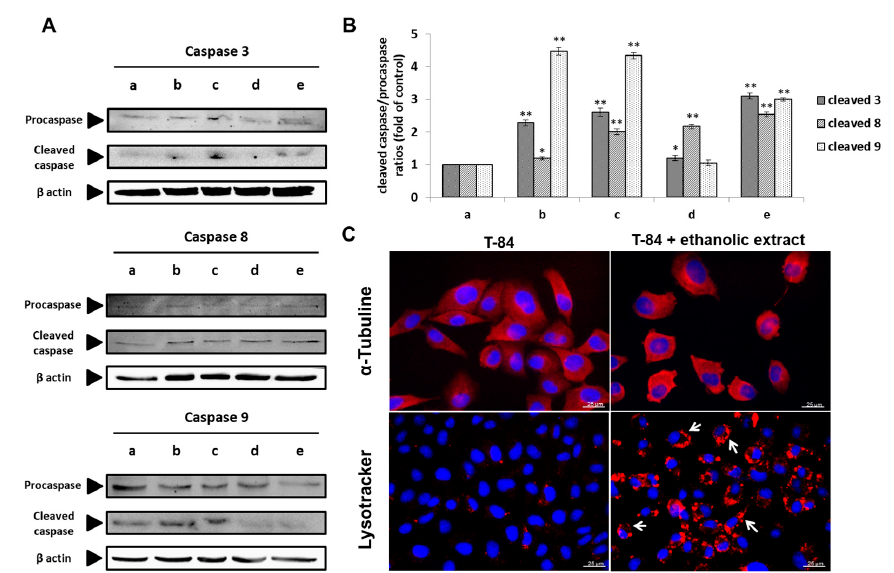
Figure 6. Mechanism of cell death by the ethanolic extract of Euphorbia lathyris . ( A ) Western blot analysis of expression of procaspase and cleaved caspase 3, 8, and 9 in T84 cells before treatment (a) and after exposure to the ethanolic extract during 12 h with IC50 dose (b), 12 h with twice IC50 dose (c), 24 h of treatment with IC50 dose (d), and 24 h with twice IC50 dose (e). ( B ) Graphic representation of Western blot densitometry analysis of bands corresponding to coefficient between cleaved caspase and procaspase 3, 8, and 9 expression after treatment with the ethanolic extract (IC50 dose and twice IC50 dose) at different time (12 h and 24 h) (b–e) compared to the untreated control (a). Data are presented as mean ± standard deviation of three independent experiments; * p < 0.05 vs. control group; ** p < 0.01 vs. control group. ( C ) Representative microscopy images of fluorescence emission from lysosomal and α -tubulin probing of T84 cell line exposed to the ethanolic extract. Formation of autophagic vesicles was evident in the treated cells